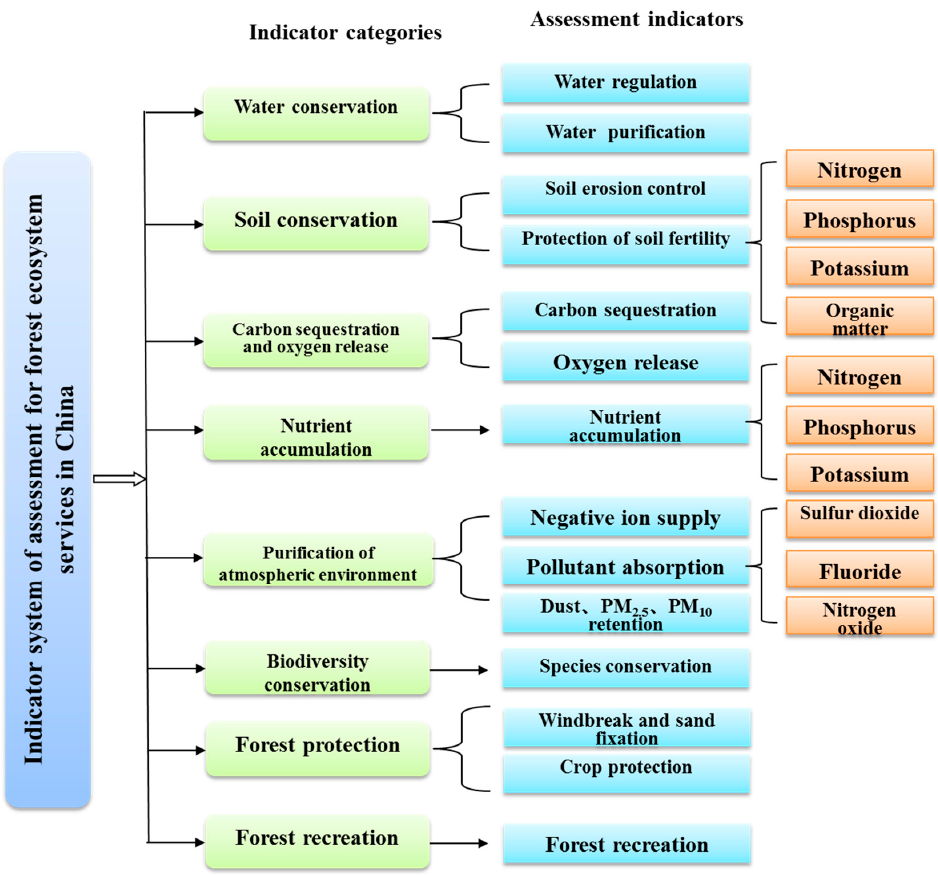
Figure 5. Indicator system used for assessing forest ecosystem services in China.